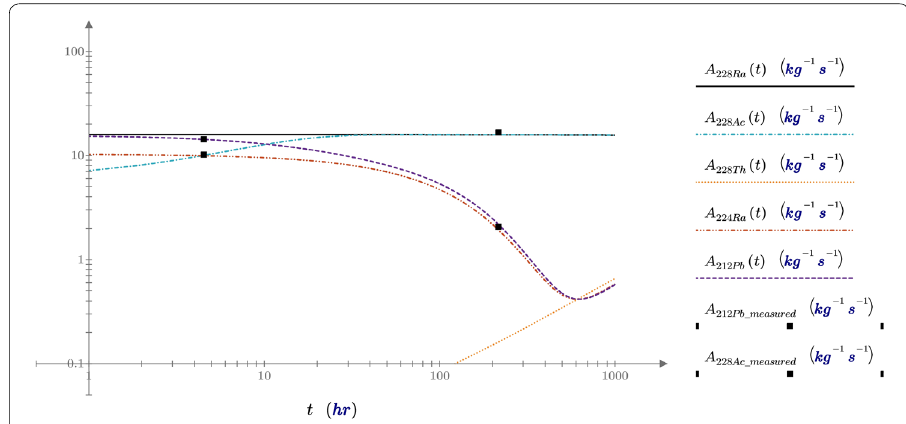
Fig. 3 Several successive transformations within the 232 Th decay series for the Bruchsal brine: The dotted lines represent the simulated time-dependent evolution over activities of 228 Ra and its daughters ( 228 Ra 228 Ac 228 Th 224 Ra). Time after sampling ( t ) is found on the x-axis. Measured activities at the times → → → of measuring t 1 and t 2 are plotted as dots. Calculations were performed by means of a CAS software (PTC